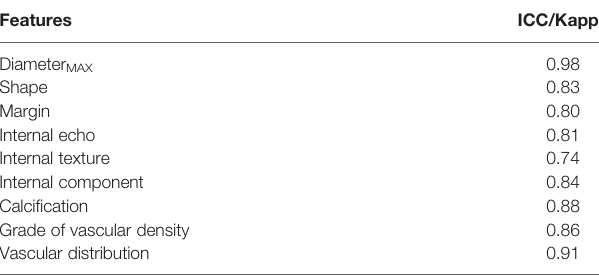
TABLE 3 | Consistency of the observers with regard to US features of soft tissue